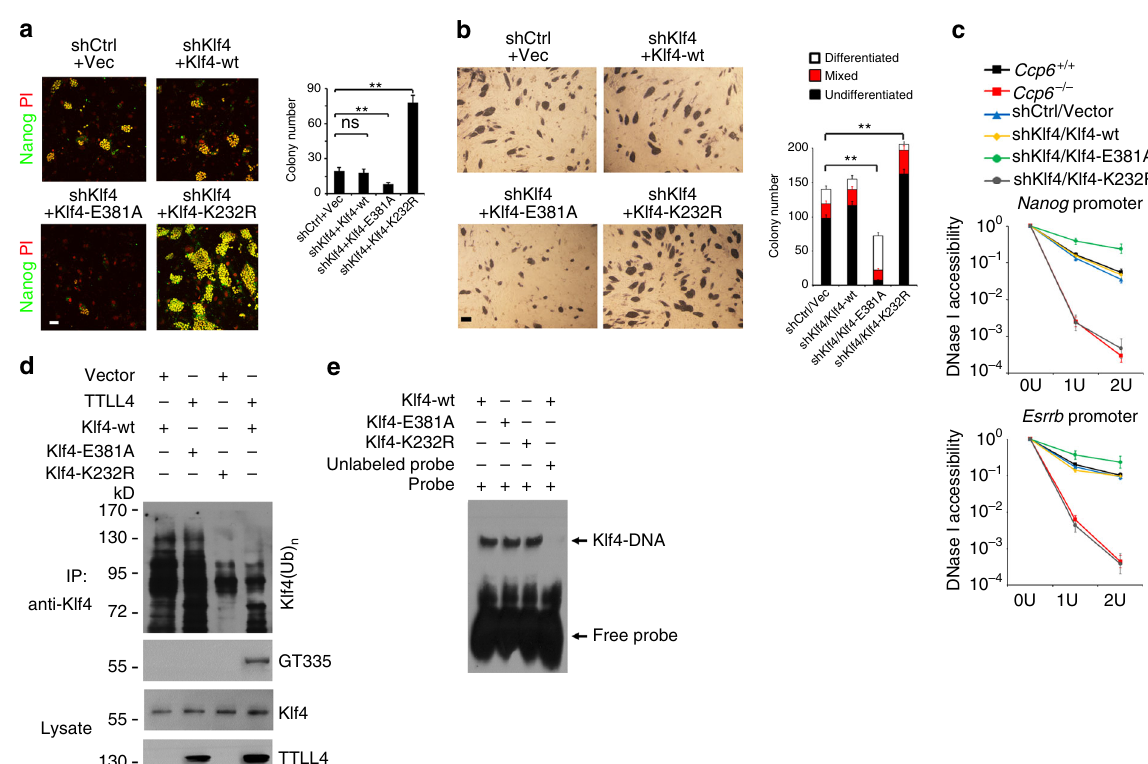
Fig. 5 A glutamylation-defective mutant of Klf4 reduces reprogramming ef fi ciency. a Klf4-wt, Klf4-E381A, or Klf4-K232R were overexpressed in Klf4- silenced 4F2A MEFs and treated with dox and cultured in ESC media for 3 weeks. Scale bar, 50 μ m. Reprogramming ef fi ciency was assayed by Nanog staining after dox removal. Nanog-positive colony numbers per 10 4 cells were calculated and shown as means ± S.D. ** P < 0.01,. n = 4. b D3 ESC cells were transfected with indicated plasmids, followed by AP staining. Scale bar, 50 μ m. AP-positive colony numbers per well were calculated as means ± S.D. ** P < 0.01. n = 5. c SSEA-1 + ES cells were isolated and an equal amount of cells were lyzed for nuclei extraction, followed by DNase I digestion. Total DNA was extracted and quantitated by qPCR with Nanog or Esrrb promoter-speci fi c primers. n = 5. d Indicated plasmids along with TTLL4 were overexpressed